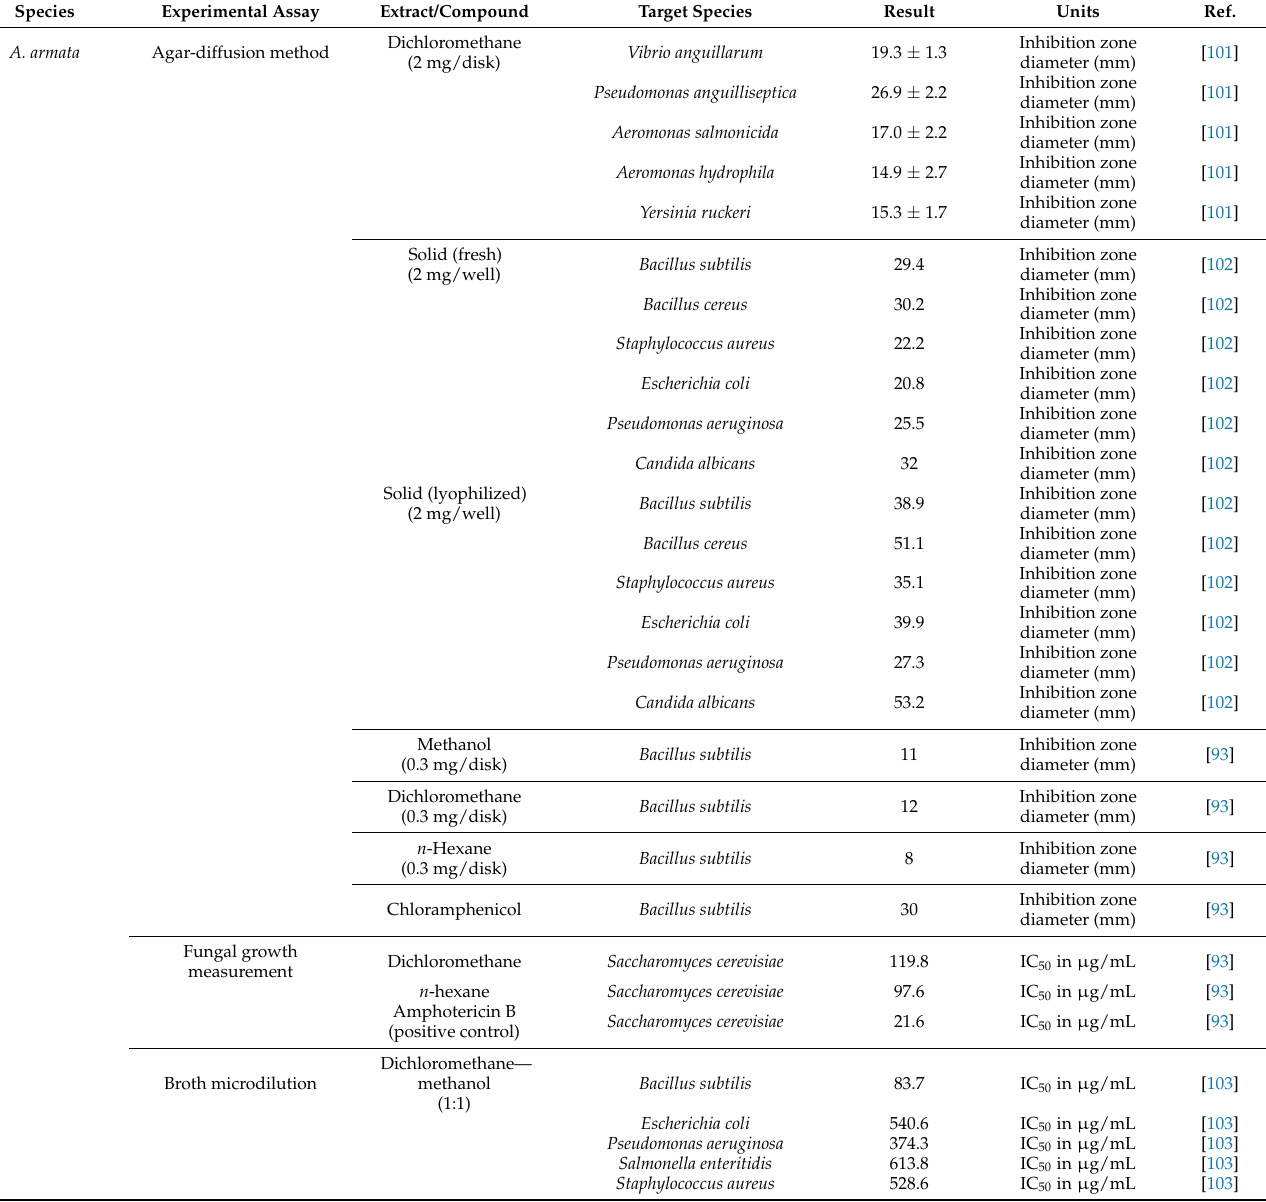
Table 3. Antimicrobial activity of Asparagopsis